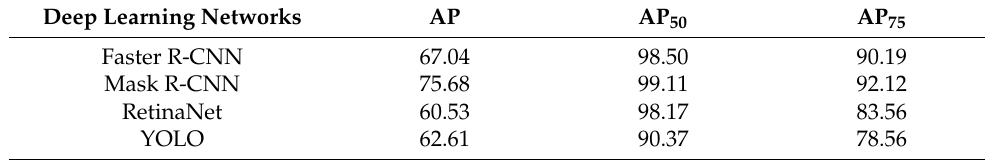
Table 3. AP scores on Tilapia dataset of Faster R-CNN, Mask R-CNN, RetinaNet, and YOLO. Deep Learning Networks